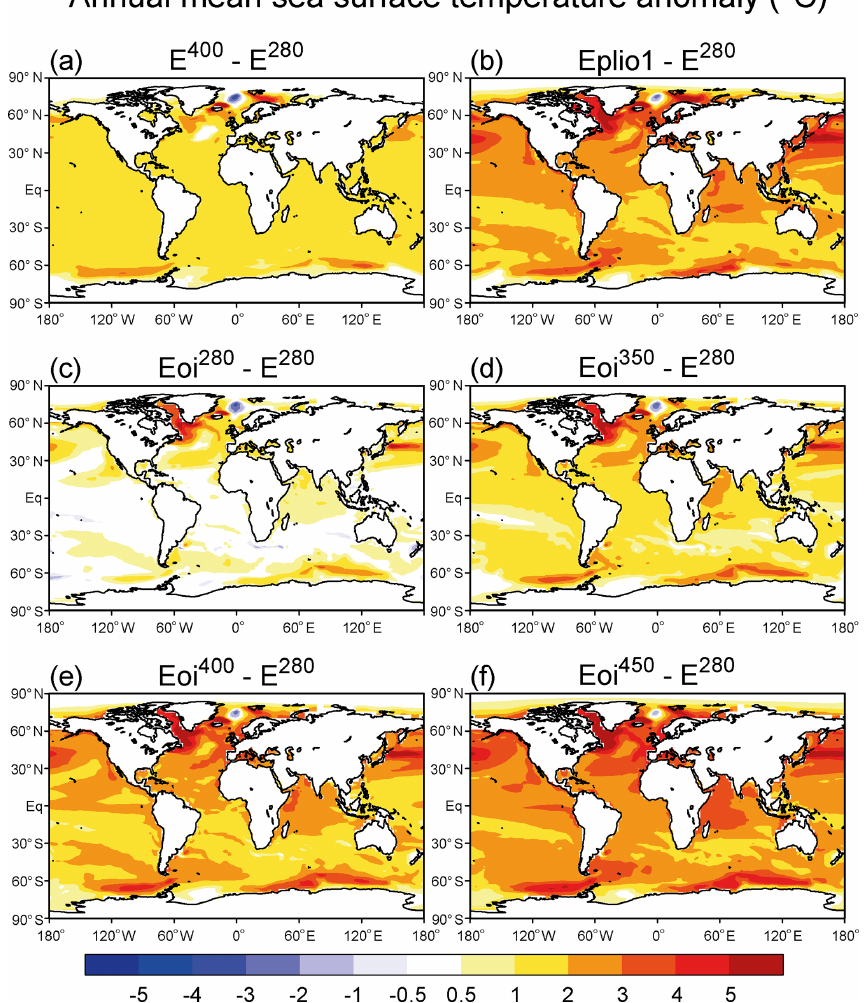
Figure 6. Annual mean sea surface temperature anomaly between six experiments and E 280 , the pre-industrial period. For a comparison of PlioMIP1 and PlioMIP2, see (b, e) . For the individual effects of CO 2 and Pliocene boundary conditions, see (a, c) ,